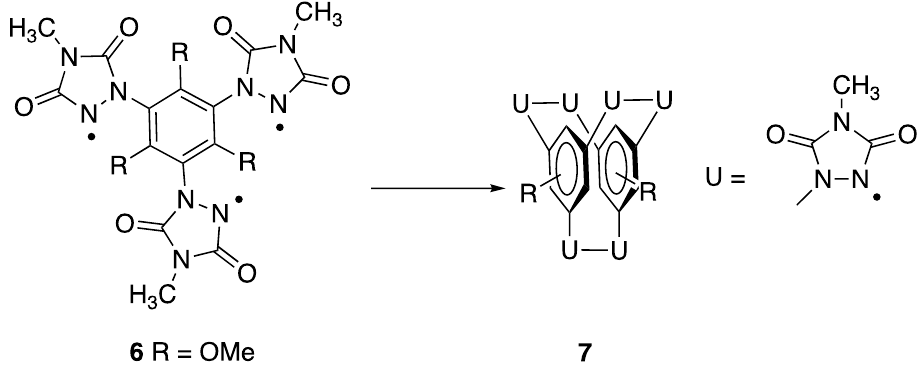
Figure 1. Structure of target triurazole, 8 .